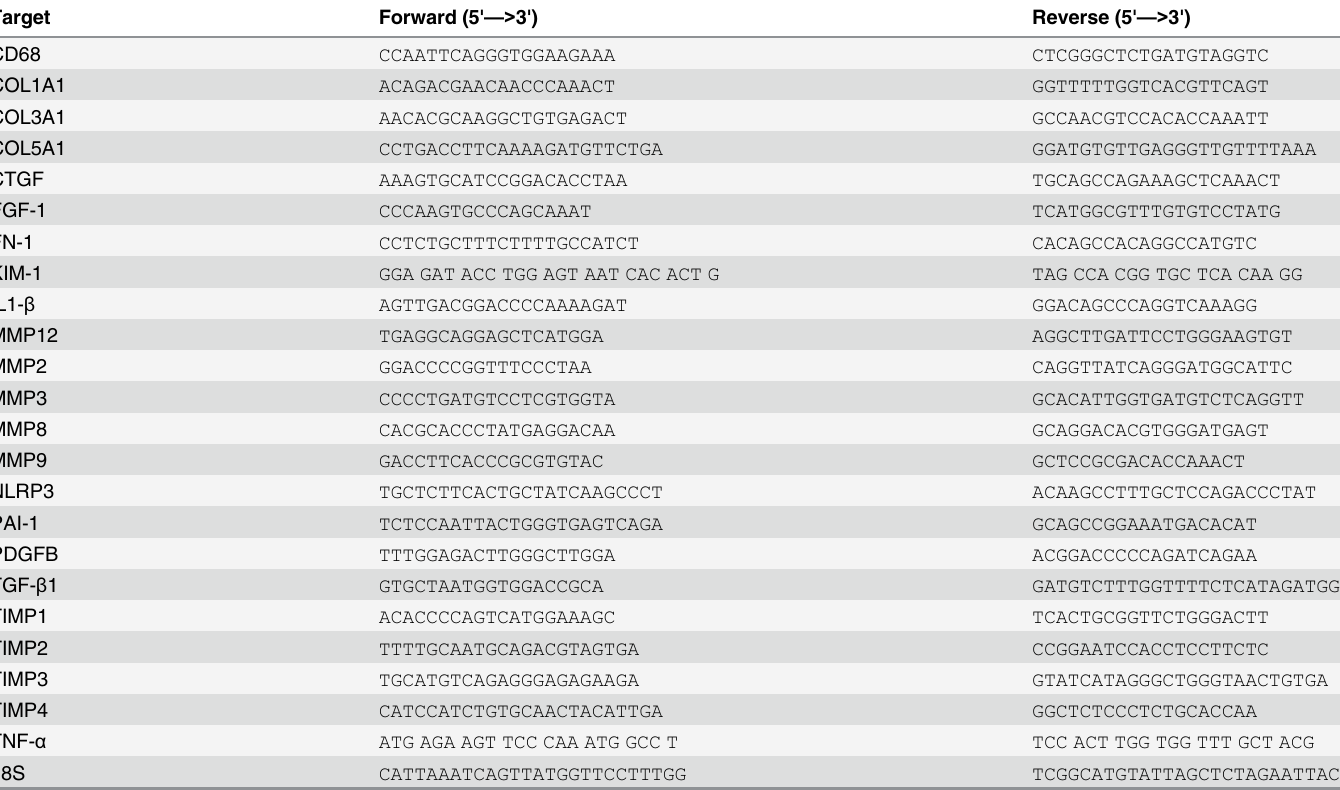
Table 1. qPCR primers used in this